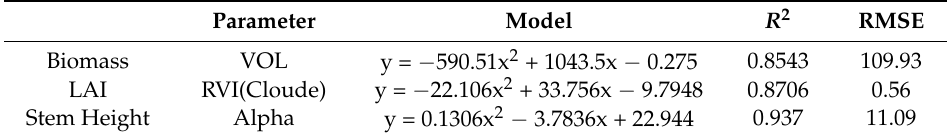
Table 7. The best models for growth parameter inversion during the whole rape growth